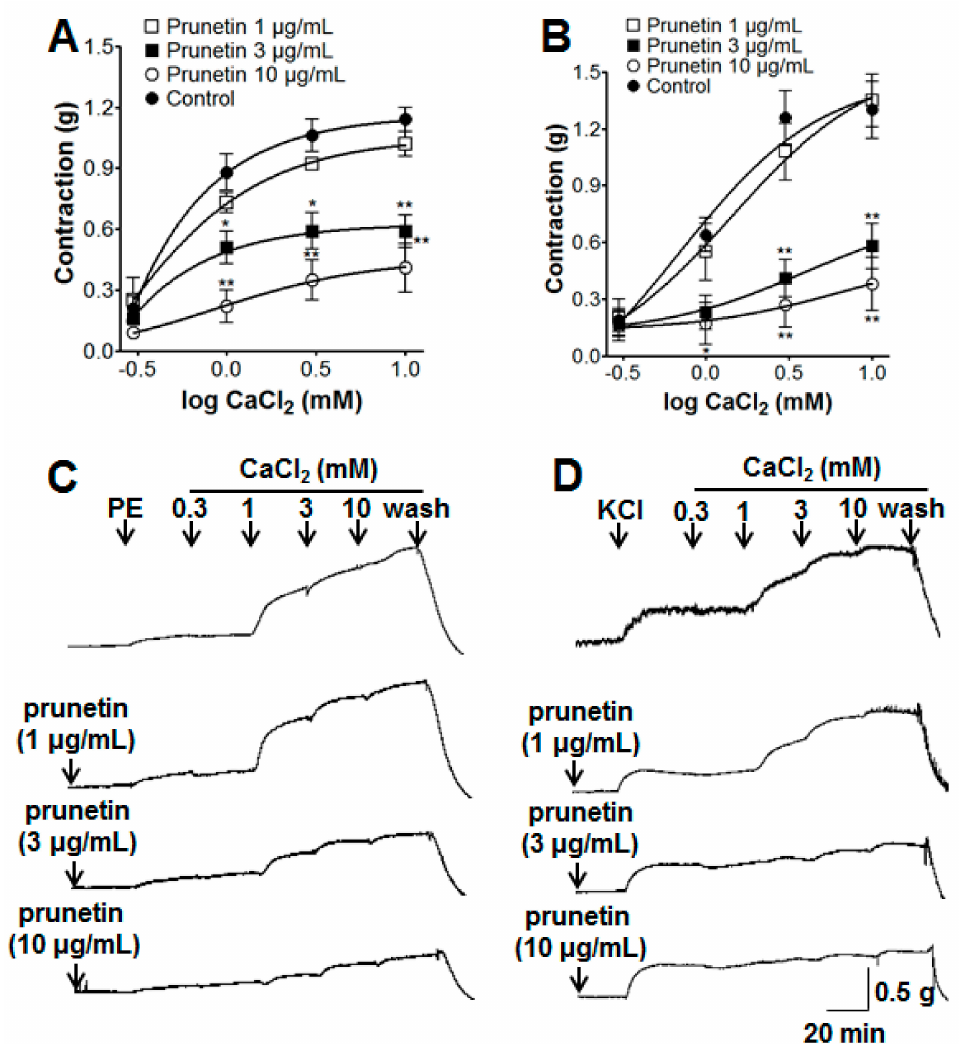
Figure 2. The inhibitory effect of prunetin (1–10 µ g/mL) on the contraction induced by CaCl 2 on endothelium-denuded aortic rings pre-contracted by phenylephrine (PE, 1 µ M) ( A , C ) or KCl (60 mM) ( B , D ) in the presence or absence (control) of prunetin. (C) and (D) are representative traces under the indicated conditions. Values are expressed as mean ± SEM ( n = 4–6). * p < 0.05, ** p < 0.01 vs. control. 2.3. Vasorelaxant Effects of Prunetin on Intracellular Ca 2+ Release Prunetin (1–30 µ g/mL) altered the PE-induced (1 µ M) contraction when the samples